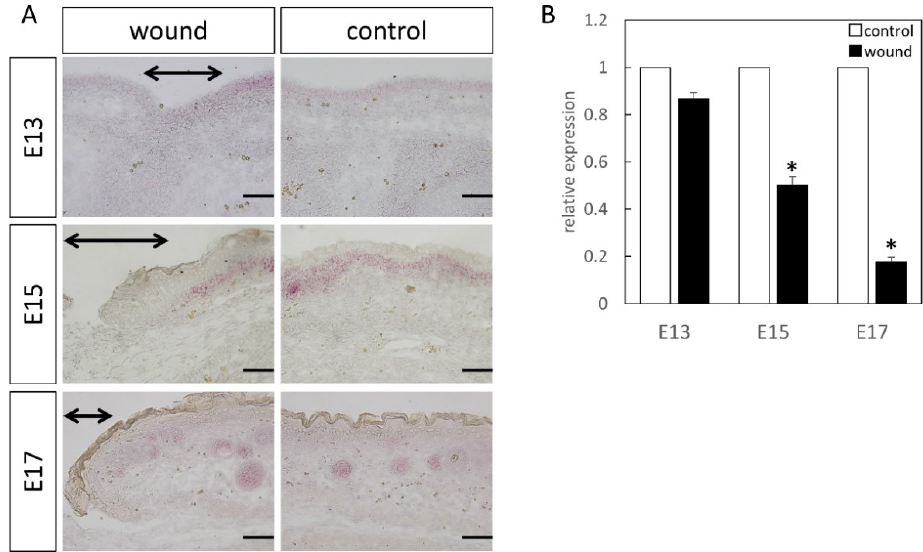
Figure 6. Localization of Lef1 (Red) in the wound. The range of the wound is indicated by an arrow. Results of Lef1 localization by ( A ) in-situ hybridization and ( B ) real-time PCR. Expression did not change at E13. However, on E15 and E17, significantly decreased expression was observed at the wound site. * p < 0 .05. Scale bar = 100 μm.